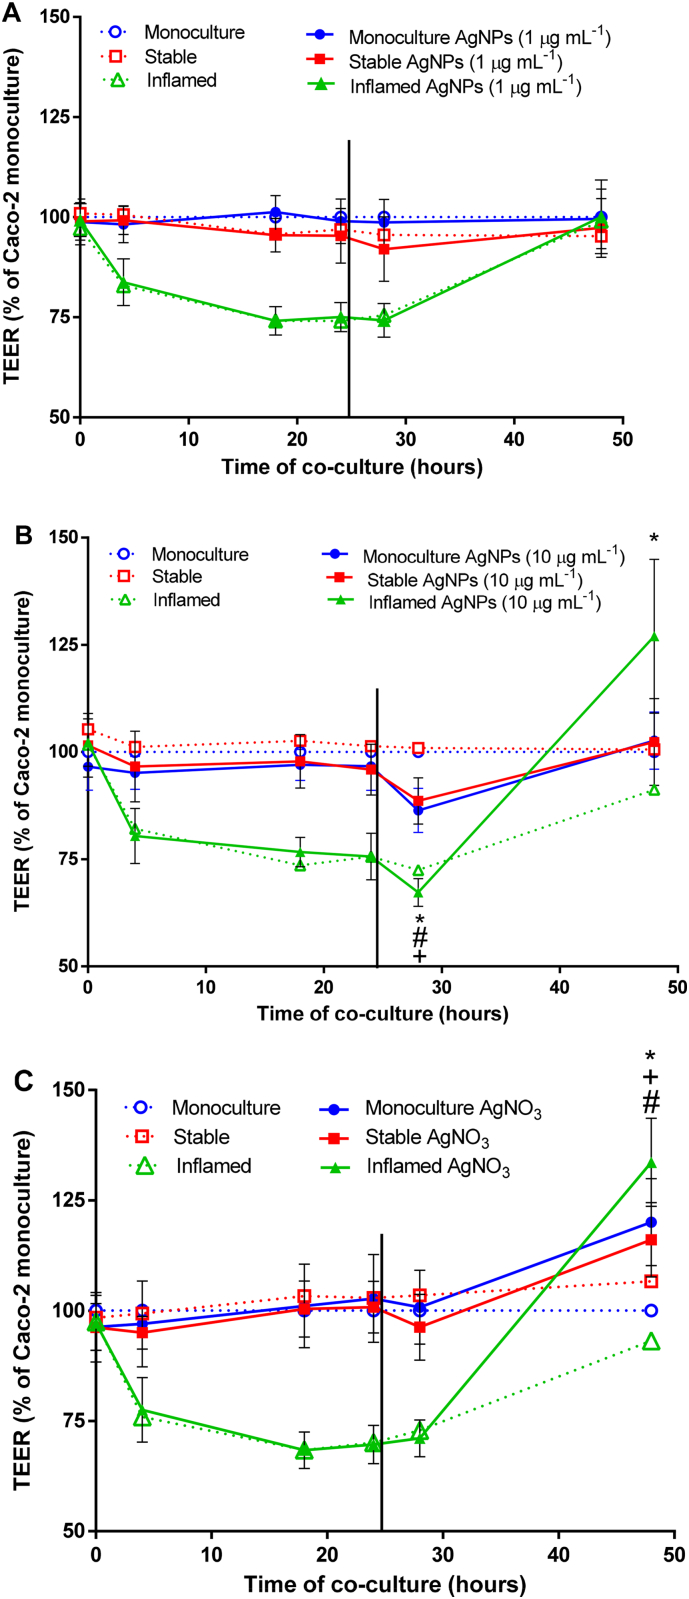
Barrier integrity measured as TEER over 48 h of co-culture and 24 h exposure to AgNPs or AgNO3.